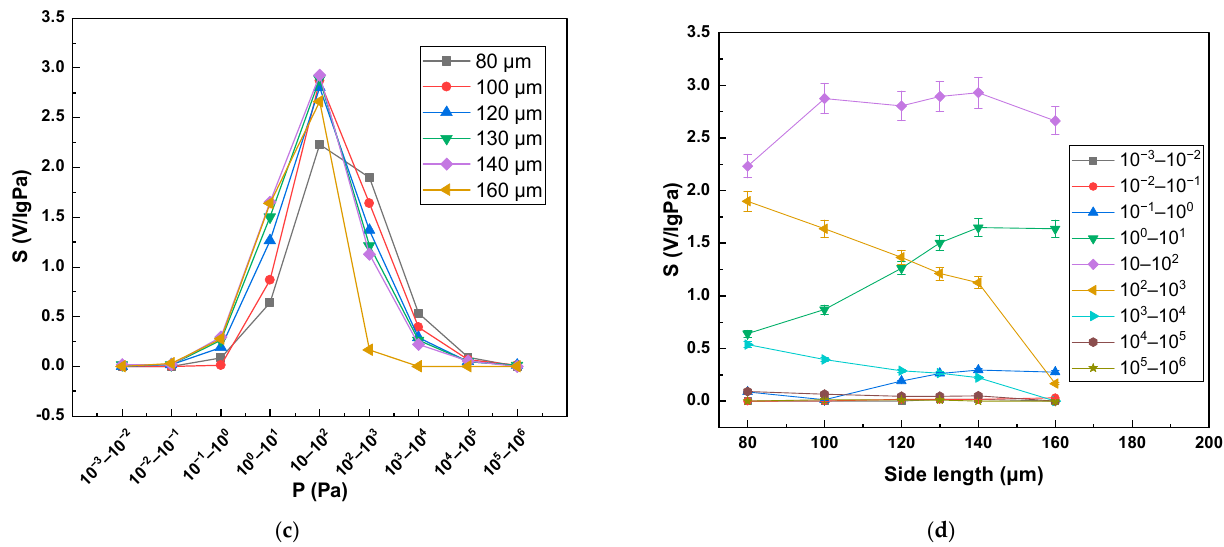
Figure 8. Range and sensitivity of Pirani gauge in different heat sensitive areas. ( a ) Variation trend of VOx temperature with pressure in Pirani equilibrium state under different thermal sensitive areas; ( b ) Variation trend of output voltage with pressure in Pirani equilibrium state under different thermal sensitive areas; ( c ) Sensitivity of Pirani gauge at different pressure intervals for different thermal sensitive areas; ( d ) The influence of the area of thermal sensitive zone on the sensitivity of Pirani gauge in different pressure ranges.